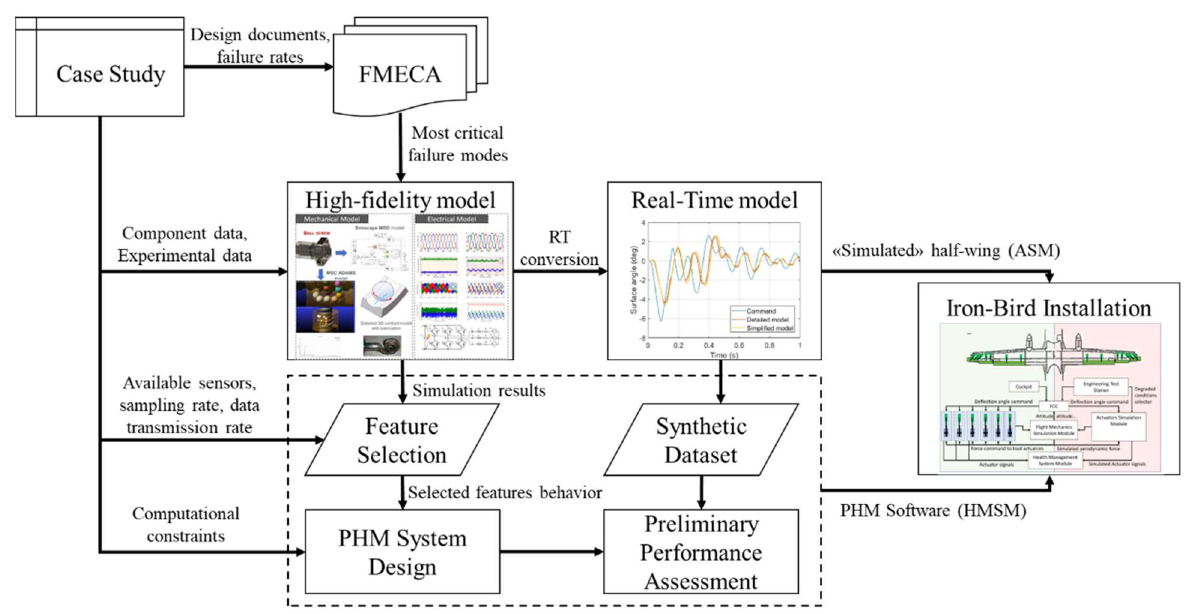
Figure 2. Research program workflow.